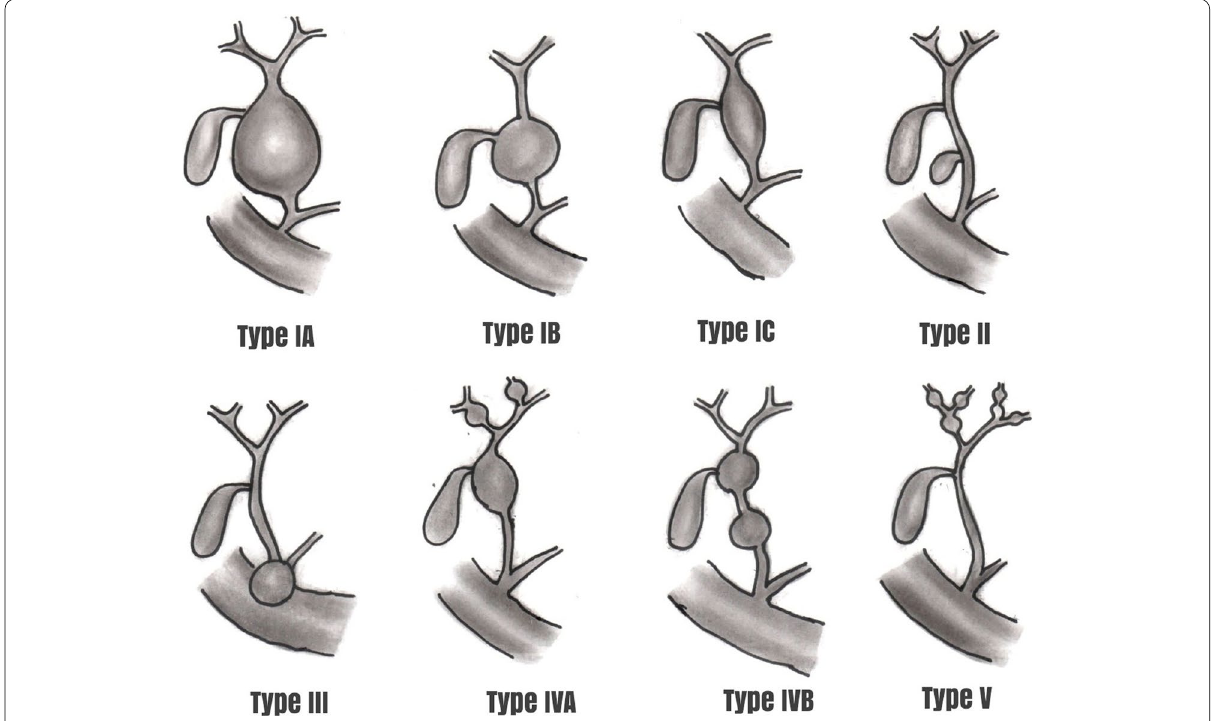
Fig. 6 Illustration of the Todani classification of bile duct